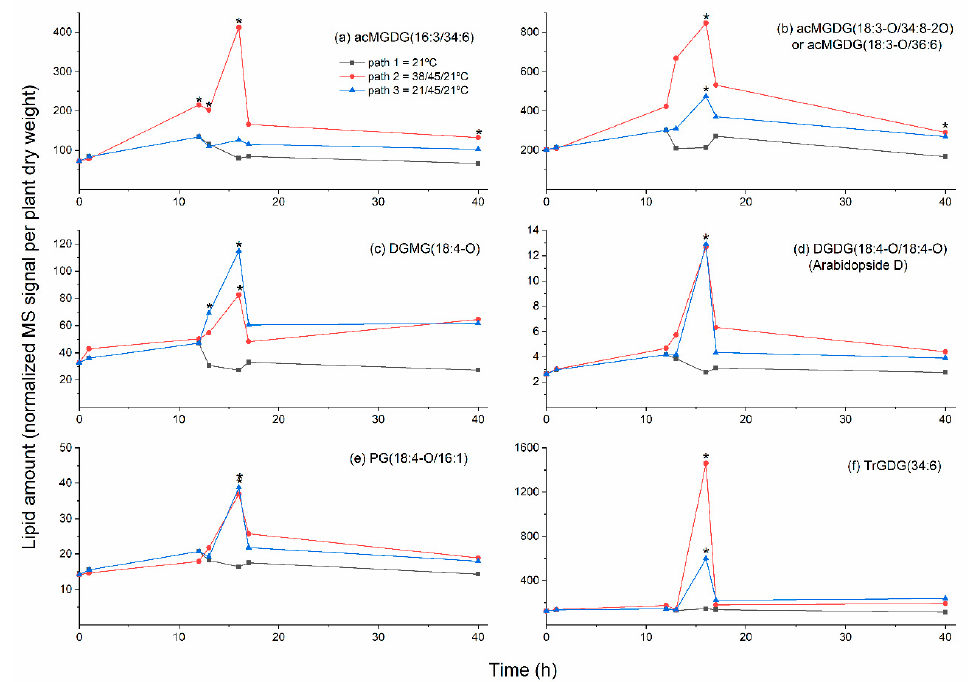
Figure 6. Levels of leaf plastid-synthesized lipids as function of time during control and heat stress treatments. Treatment details are shown in Figure 1. ( a ) acMGDG(16:3 / 34:6); ( b ) acMGDG(18:3-O / 34:8-2O) or acMGDG(18:3-O / 36:6);( c )DGMG(18:4-O);( d )DGDG(18:4-O / 18:4-O),i.e.,ArabidopsideD;( e )PG(18:4-O / 16:1); ( f ) TrGDG(34:6). A mixed effects ANOVA model was fitted to the data, and pairwise comparisons were made between paths; p -values were adjusted for FDR. An asterisk indicates that the value is significantly different from the control (Path 1) value for that time point ( p < 0.05), using a p -value adjusted for false discovery rate (FDR; Tables S4 and